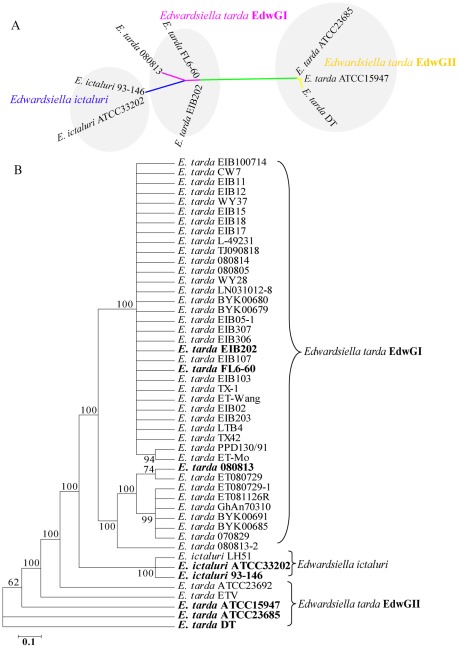
Phylogenetic tree of Edwardsiella species.(A) Maximum likelihood phylogeny based on all filtered SNPs across 8 Edwardsiella genomes. Branches are colored according to the main phylogeographic lineages of Edwardsiella bacteria. (B) NJ tree of 48 Edwardsiella strains inferred from concatenated alignments of partial coding sequences of glyA, mdh, pgi, fusA, aspA and tpi genes with 100 bootstrap iterations. Strains investigated in this study are indicated in bold font.